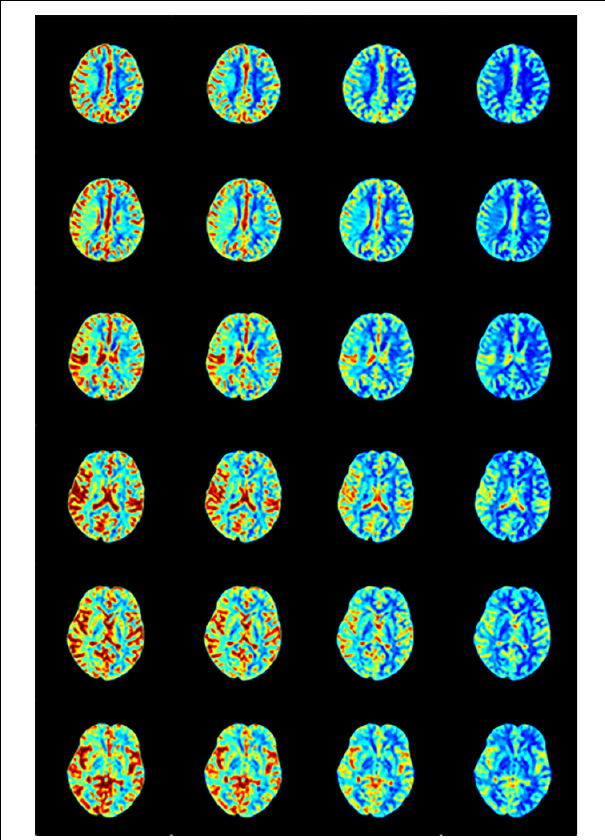
FIGURE 8 | Tmax calculated by AIF from (A) Manual, (B) MS3DCNN, (C) fuzzy c-means, and (D) U-Net3D + fuzzy c-means in each column from left to right.